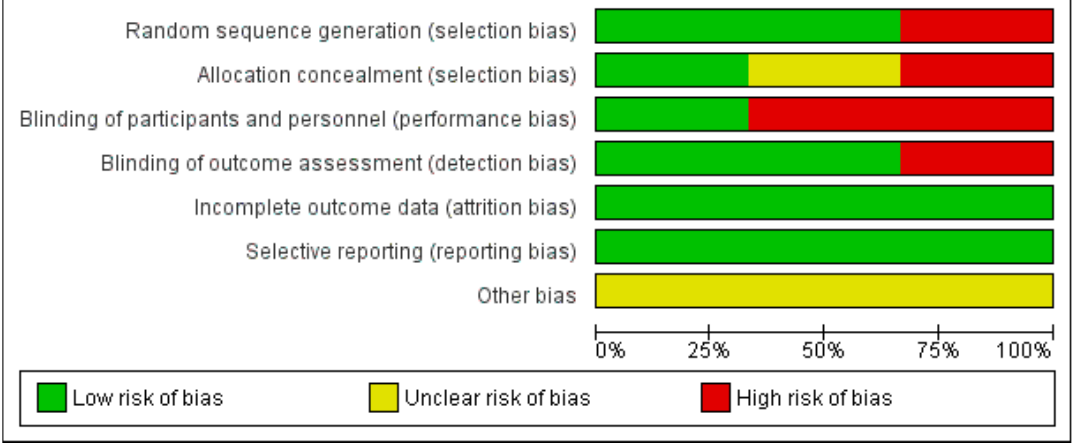
Figure 3. Risk of bias graph.